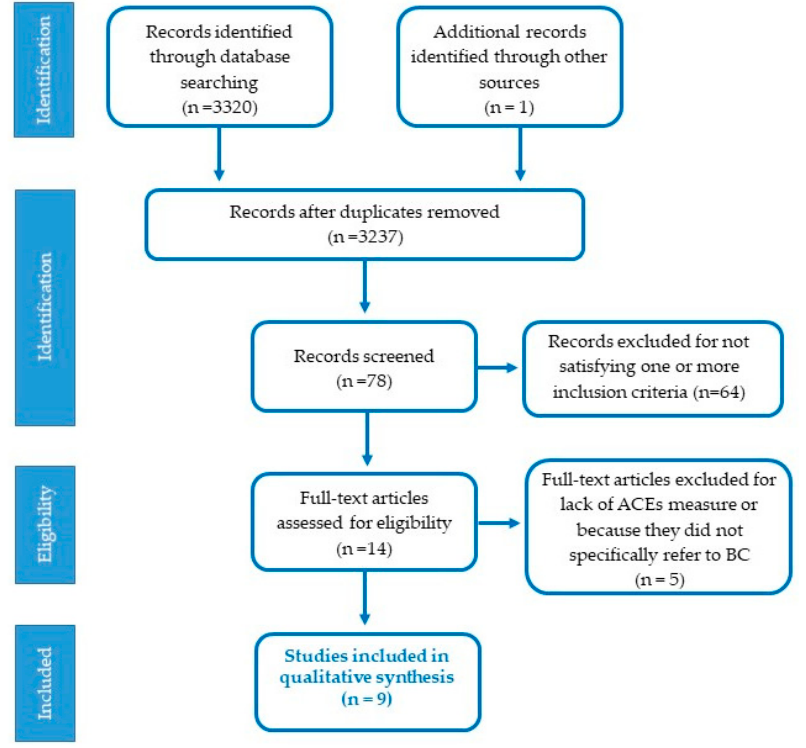
Figure 2. Selection process of the studies included in the paper.